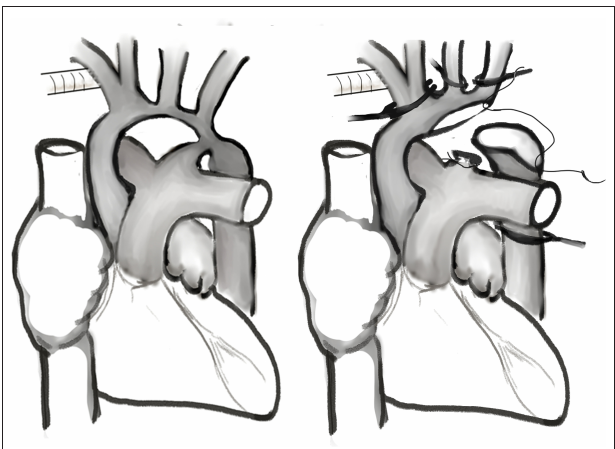
FIGURE 1 | Neonatal aortic arch repair with selective cerebral